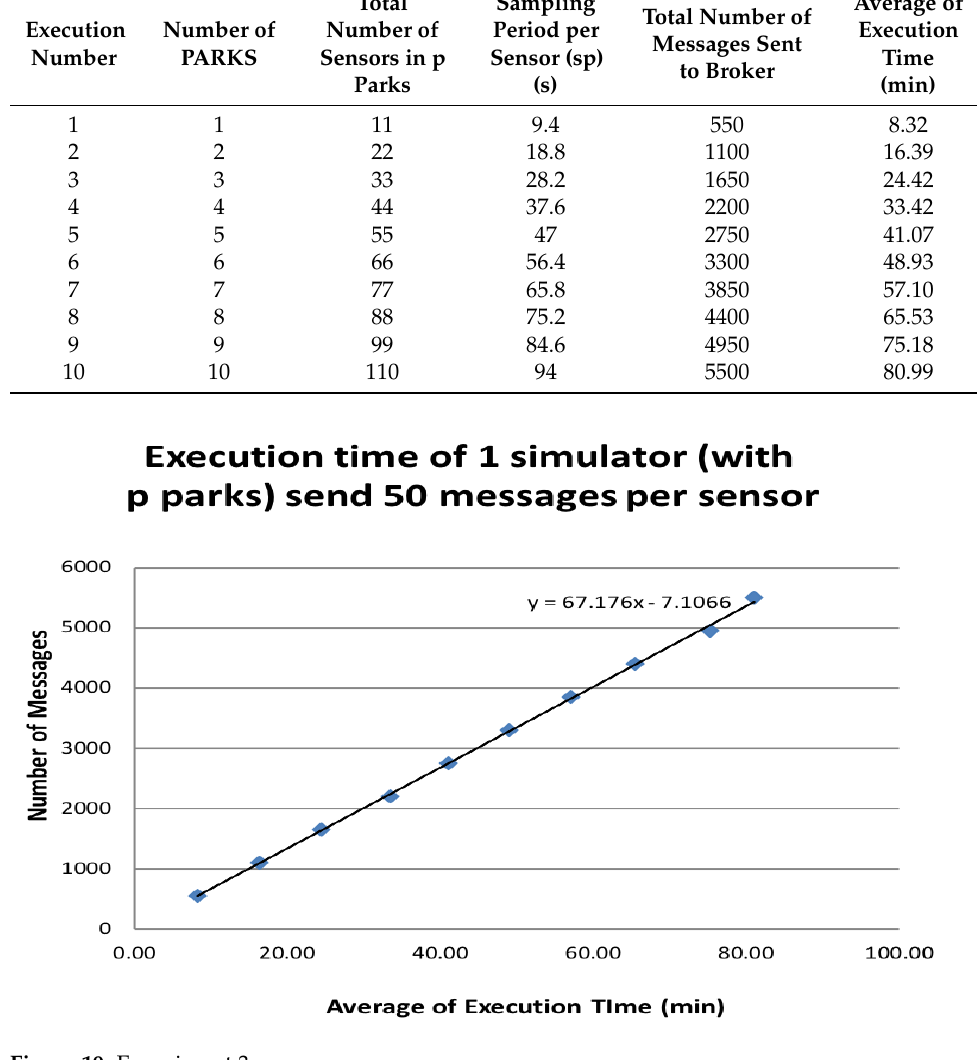
Figure 19. Experiment